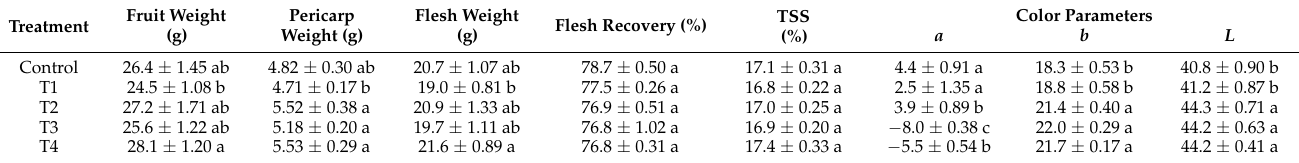
Table 1. Effect of CPPU applied at different stages on fruit appearance and quality at commercial harvest (result of 2017).